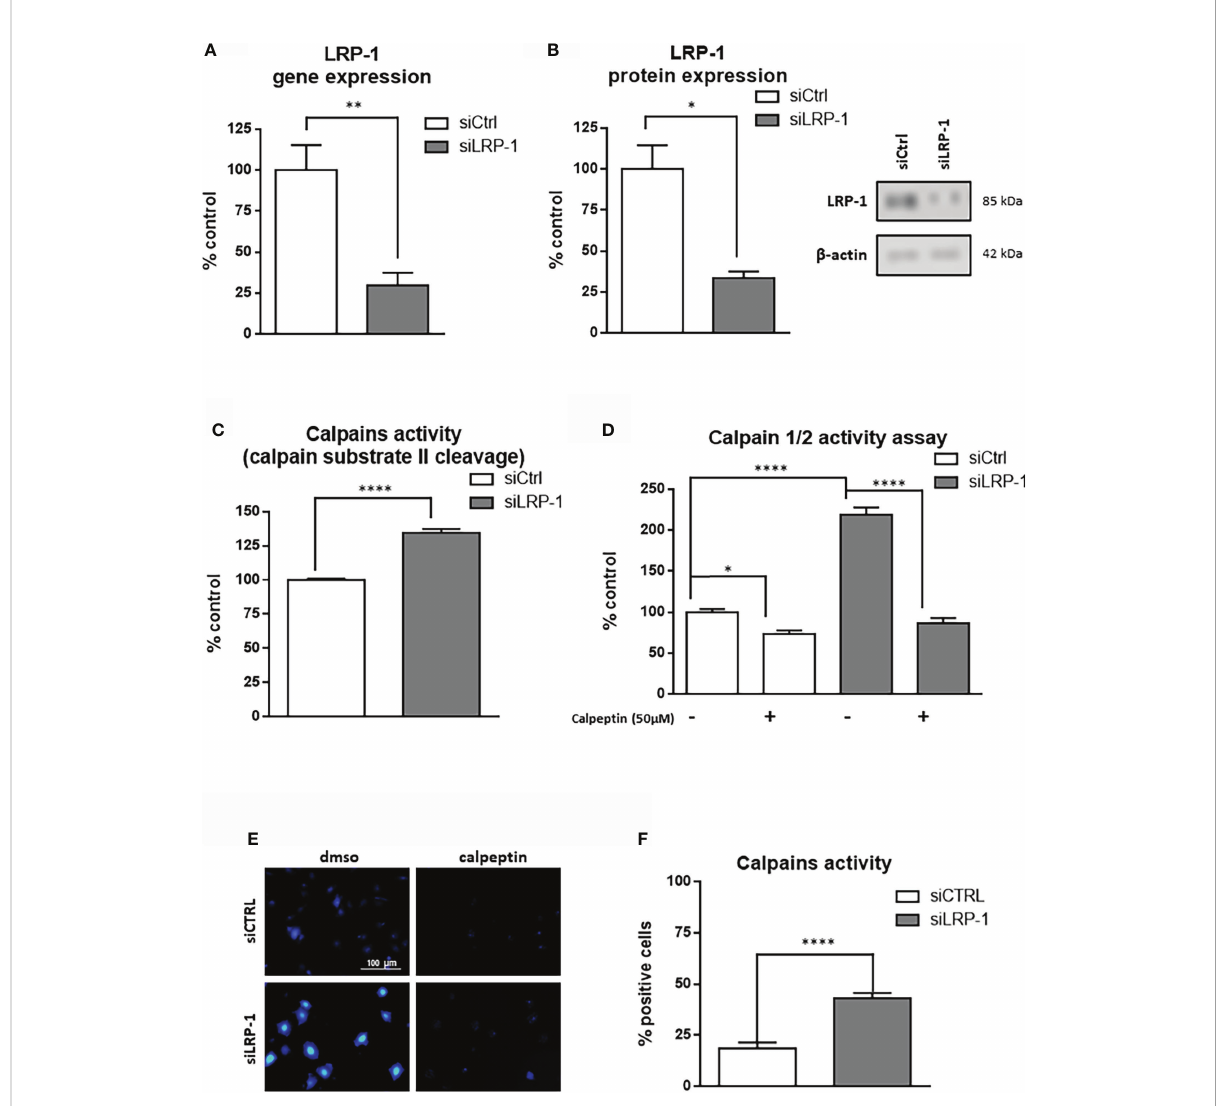
FIGURE 1 LRP-1 controls calpain activity in carcinoma cells. FTC133 cells were transfected with siRNA against LRP-1 expression (siLRP-1) or non-targeting control sequences (siCtrl) and total RNA were extracted after 48 hours. The transcriptional level of LRP-1 expression was assessed by RT-qPCR, using b -actin as a normalization control (A) . The LRP-1 protein expression was assessed by western blot, using b -actin as a normalization control. A representative picture of immunoblots is presented (B) . Whole extracts FTC133 cells transfected with siRNA sequences were used to test their ability to degrade the calpain substrate II, measured by spectro fl uorimetry. Results are expressed as percentage of control after background fl uorescence subtraction (C) . Same extracts were used to measure calpain activity by using Innozyme Calpain 1/2 Activity Assay Kit in the presence or absence of 50µM of calpeptine to ensure the speci fi city of the reaction (D) . Intracellular activity of calpains was visualized by fl uorescence microscopy in intact cells treated with cell permeant calpain substrate BOC-LM-CMAC (E) . The percent of cells harboring strong intracellular accumulation of fl uorescent CMAC, above fl uorescent developed in presence of 50µM of calpeptin, was quanti fi ed (F) . Each value is mean ± sem for at least four independent experiments, each performed in triplicate. *, P < 0,05; **, P < 0,01; ****, P <